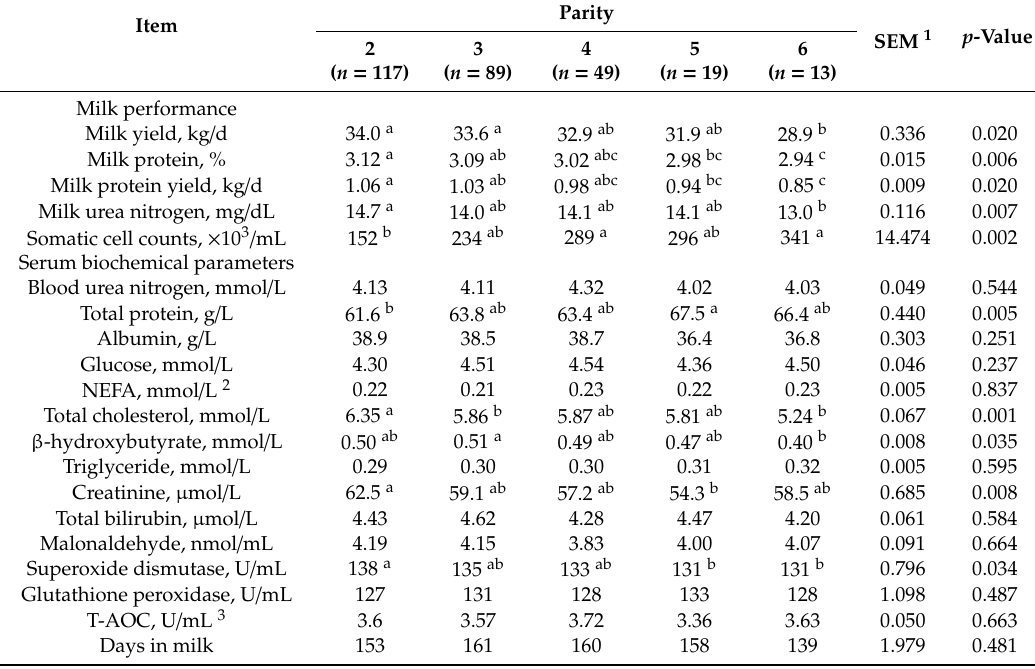
Table 2. E ff ects of parity on milk performance and blood biochemical